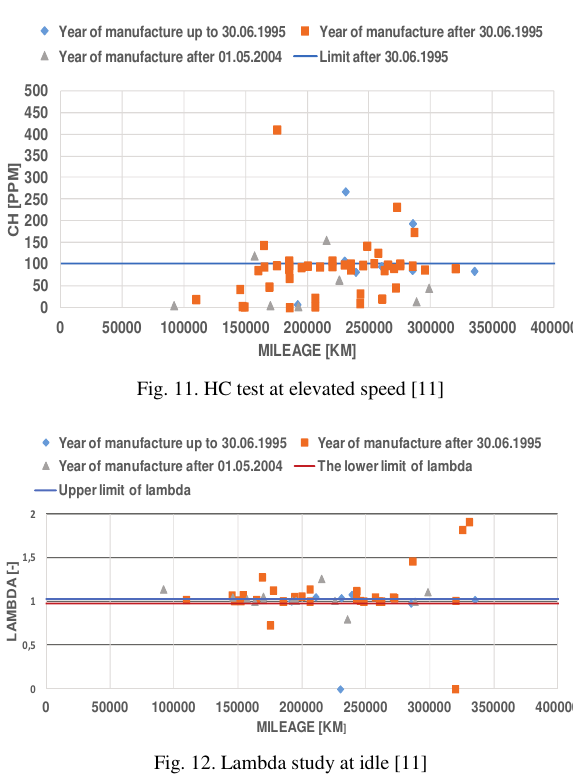
Fig. 12. Lambda study at idle